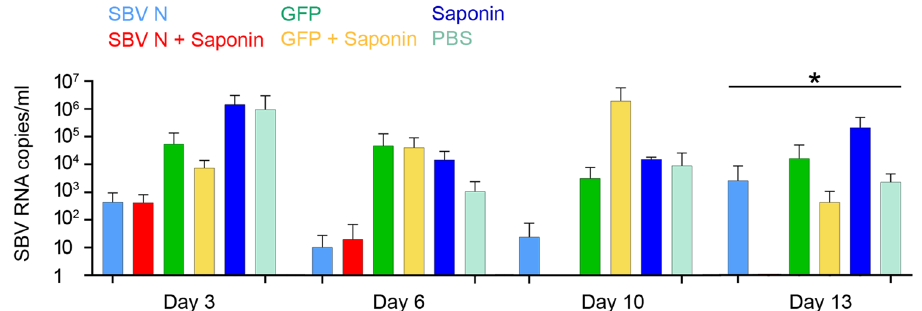
Figure 3. Viremia of A129 mice following viral challenge with virulent SBV. Blood from each vaccinated mouse was taken at 3, 6, 10 and 13 dpi. RNA was extracted from 100 µl of blood, and eluted in the same volume using the extraction technique described in the “Materials and methods” section. Values presented are the number of SBV genome copies/ml. Error bars are presented as the standard deviation from the mean. Asterisk denotes statistical significance, with P < 0.05, as determined by the one-way ANOVA